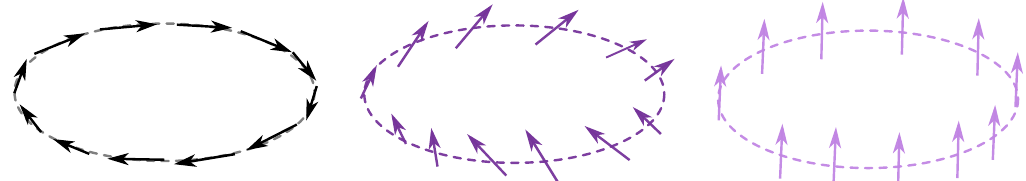
Figure 6.4: Removal of a vortex by rotating vectors out of the plane. This is some- times called “escape in the third dimension”, and shows the vortex is not a stable topo- logical defect for order parameters that can be represented by a three-dimensional